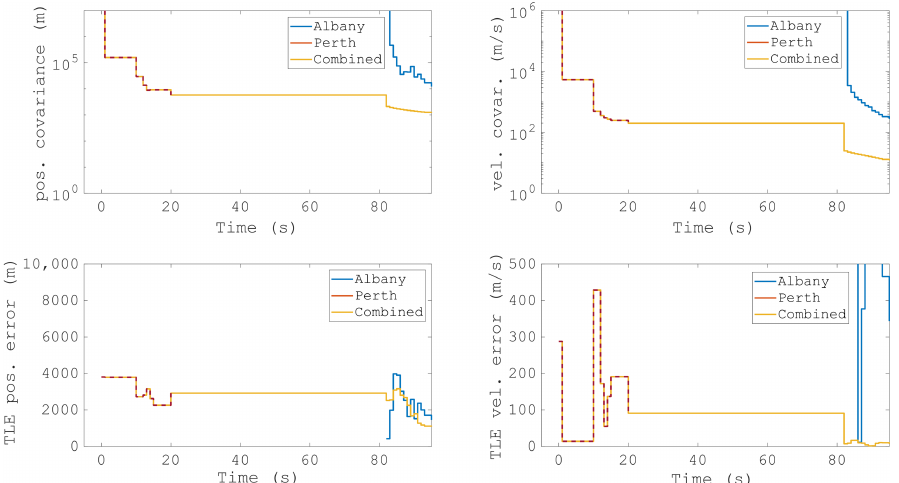
Figure 19. The resulting orbit predictions from the multistatic measurements from Figure 18. The top panels show the covariance of the position estimate and the velocity estimate. As the detections from each bistatic pair are not coincident, the combined errors will be initially identical to Perth’s. The bottom panels show the mean errors when compared with the two-line element